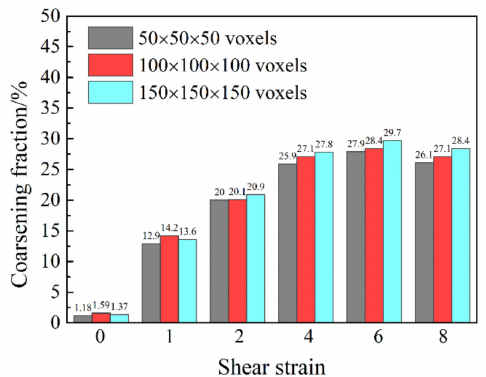
Figure 4. Dependence of the fraction of grain coalescence on the number of voxels constituting the 3D polycrystal as a function of